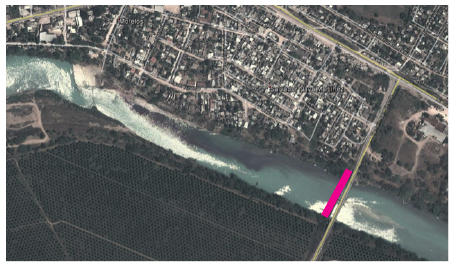
Figure 3. First transect and location of control section.